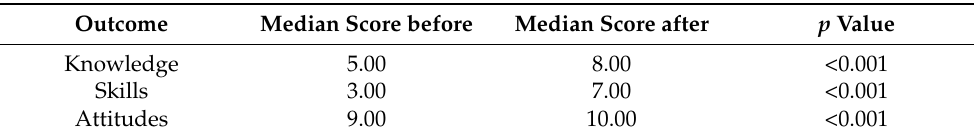
Table 2. Wilcoxon Signed Ranked Tests Assessing Differences in Perceived Knowledge, Skills, and Attitudes before and after Completing the CONVERGE Disaster Mental Health Training